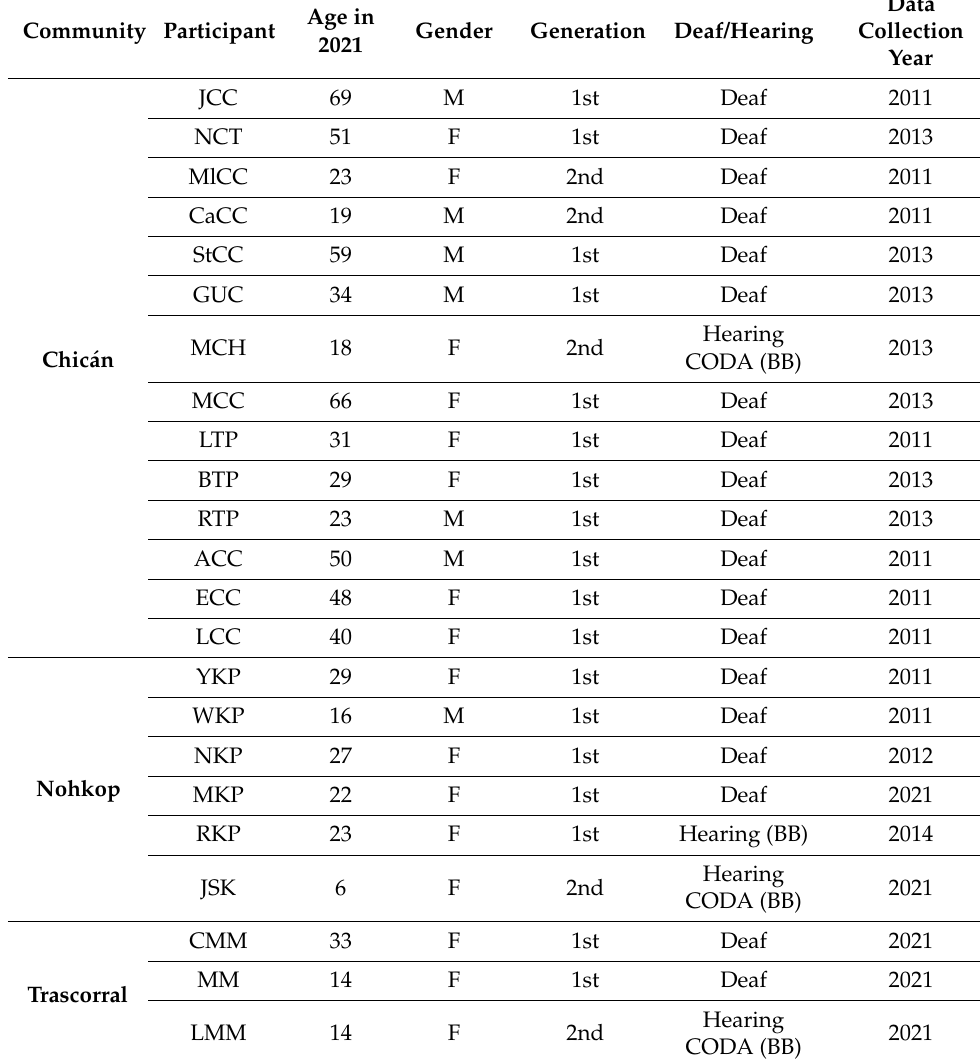
Table 2. Participants data (including interactional